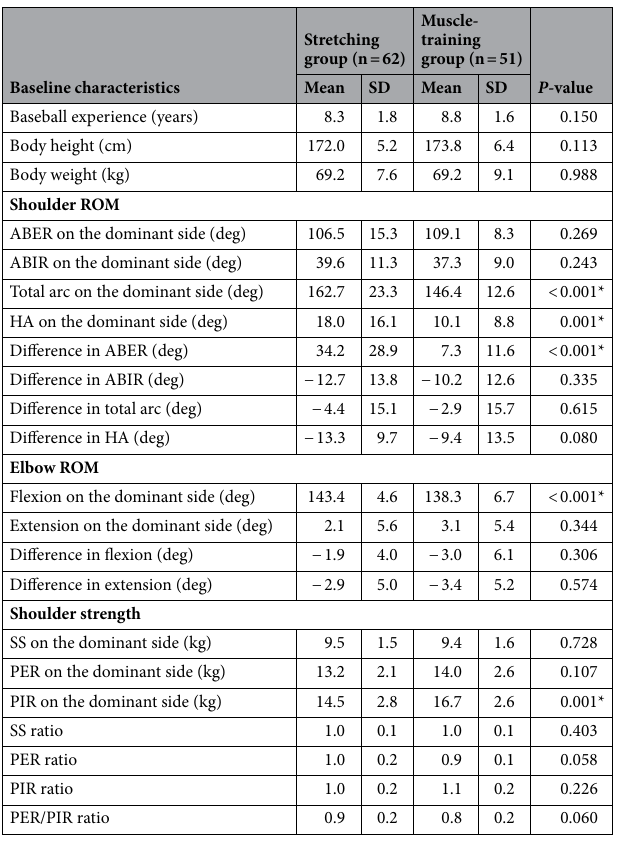
and 9.8% (n = 5), respectively. The median survival times were 52.5 and 49.0 days, respectively (Fig. 3). The muscle-training group had a lower risk of injury than the stretching group (hazard ratio [HR] = 0.489; 95% con-